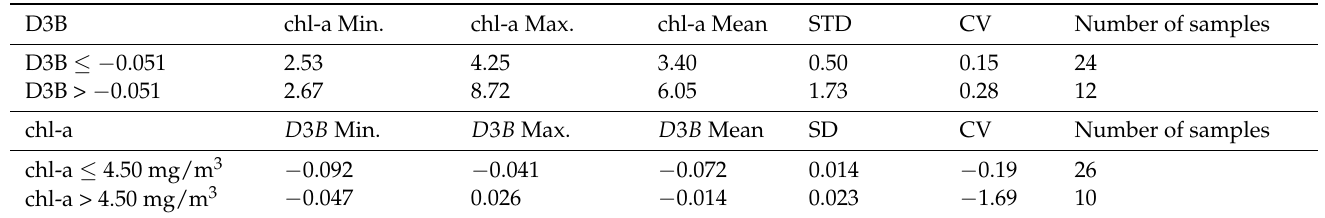
Table 4. Descriptive statistics of the water samples with D3B = − 0.051 and chl-a = 4.5 mg/m 3 as